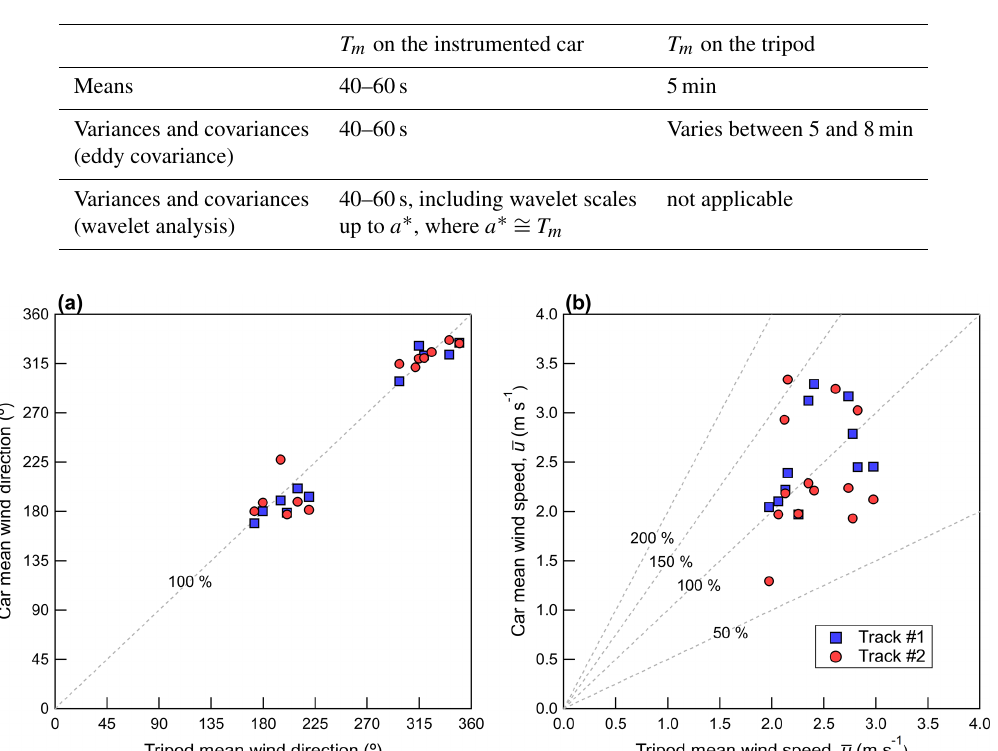
Table 2. The averaging periods ( T m ) used to calculate atmospheric means, variances, and covariances on the instrumented car and stationary roadside tripod. T m for variances and covariances are calculated from Taylor’s hypothesis ( T m = L/u ), with an L = 1000m track length. On the instrumented car, we have u ∼= s , where s is the near-constant vehicle speed over the 1000m track, but for the tripod, u is the mean wind speed measured on the tripod and calculated from 5min averages.